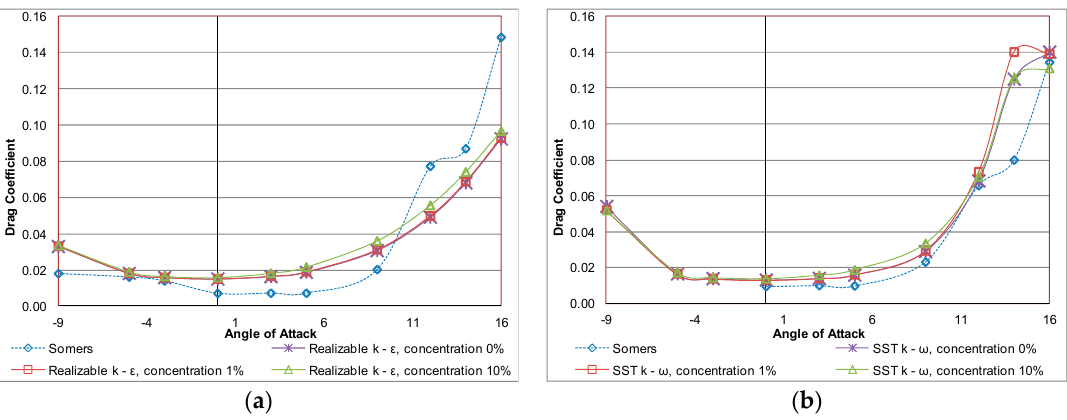
Figure 6. Comparison between reliable experimental data and simulation results of the drag coefficient curve for an S809 airfoil for ( a ) realizable k– ε ; and ( b ) SST k– ω turbulence models at Re = 2 × 10 6 for one-phase and two-phase flows consisting of two different concentrations of sand particles in the air.